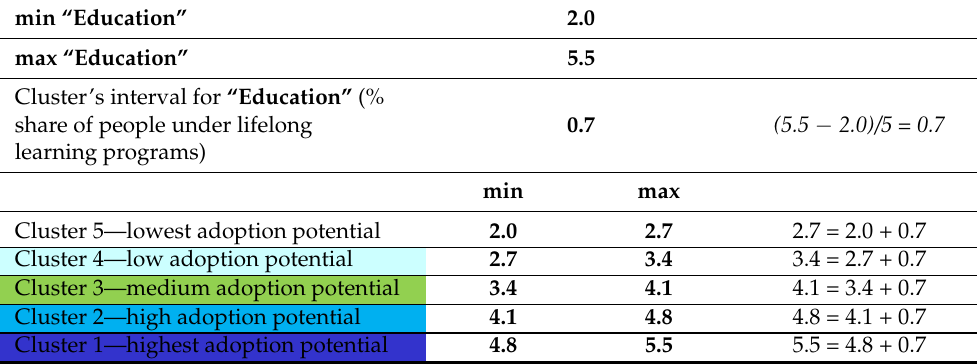
Table 6. Calculations for the “cluster interval” for variable “Education” (% share of people under lifelong learning programs)